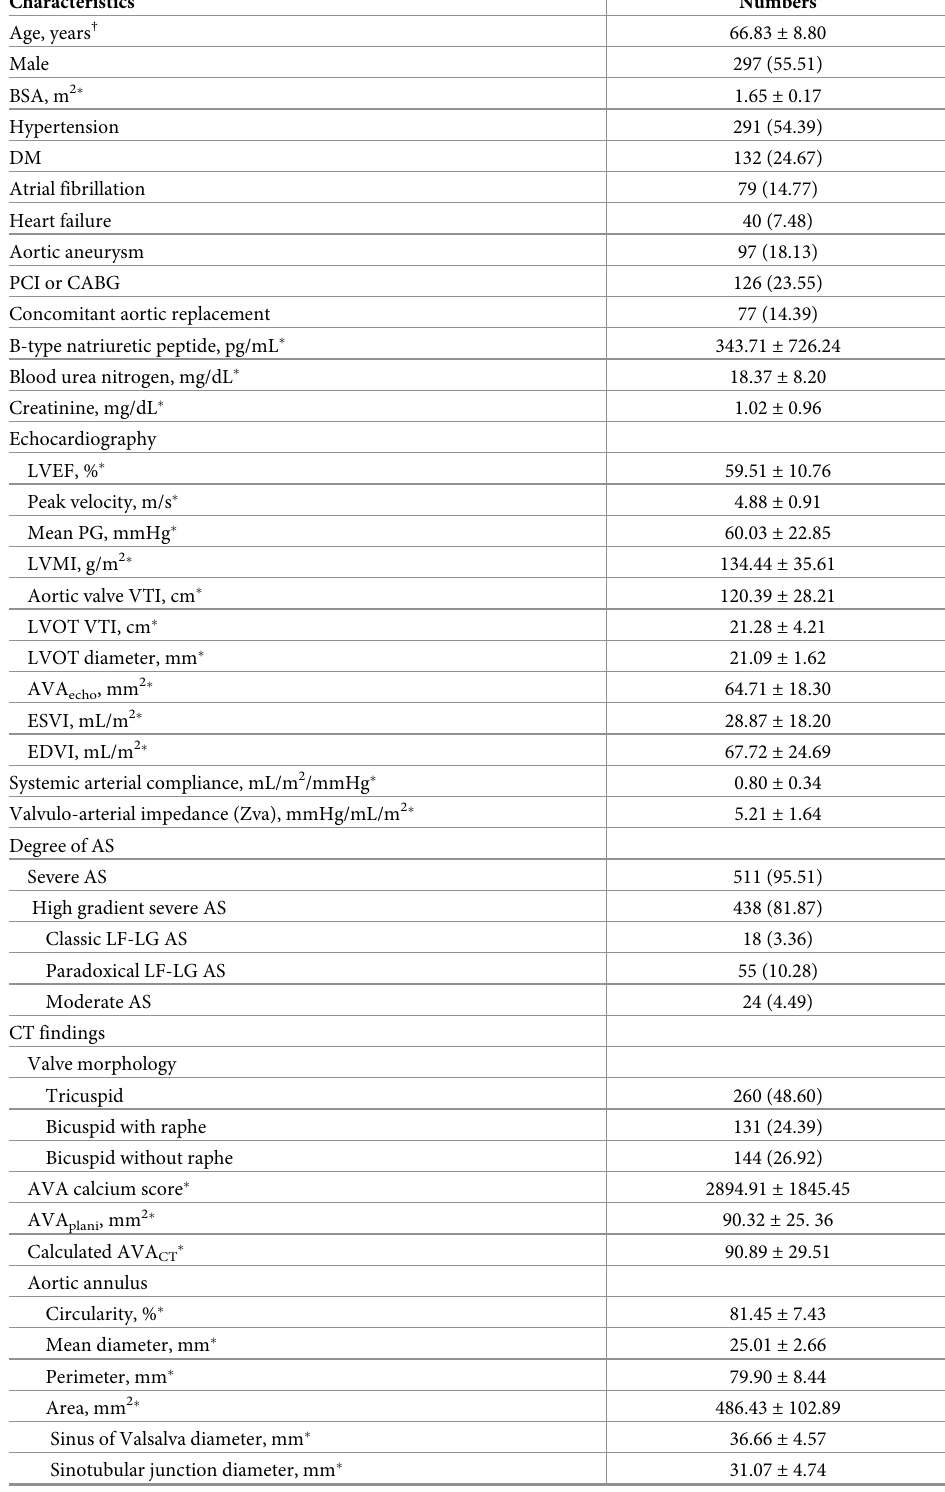
Table 1. Clinical characteristics and echocardiographic findings of study